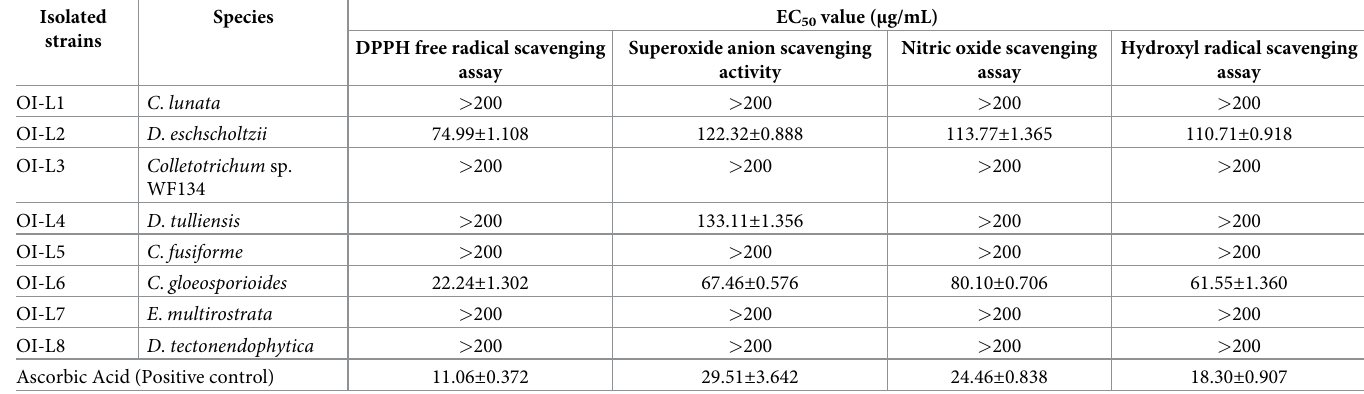
Table 2. Antioxidant activity of EA extract of identified fungal endophytes associated with the leaf of O . indicum . Isolated